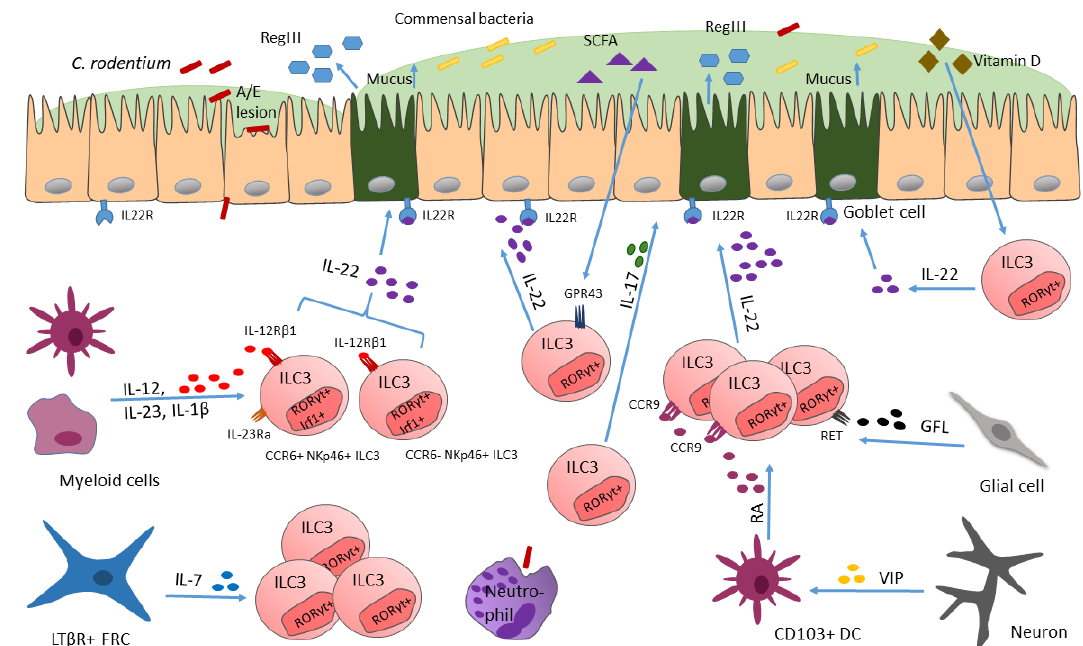
Figure 2. ILC3s reacting to C. rodentium invasion. Upon CR infection cytokines such as IL-23 and IL-